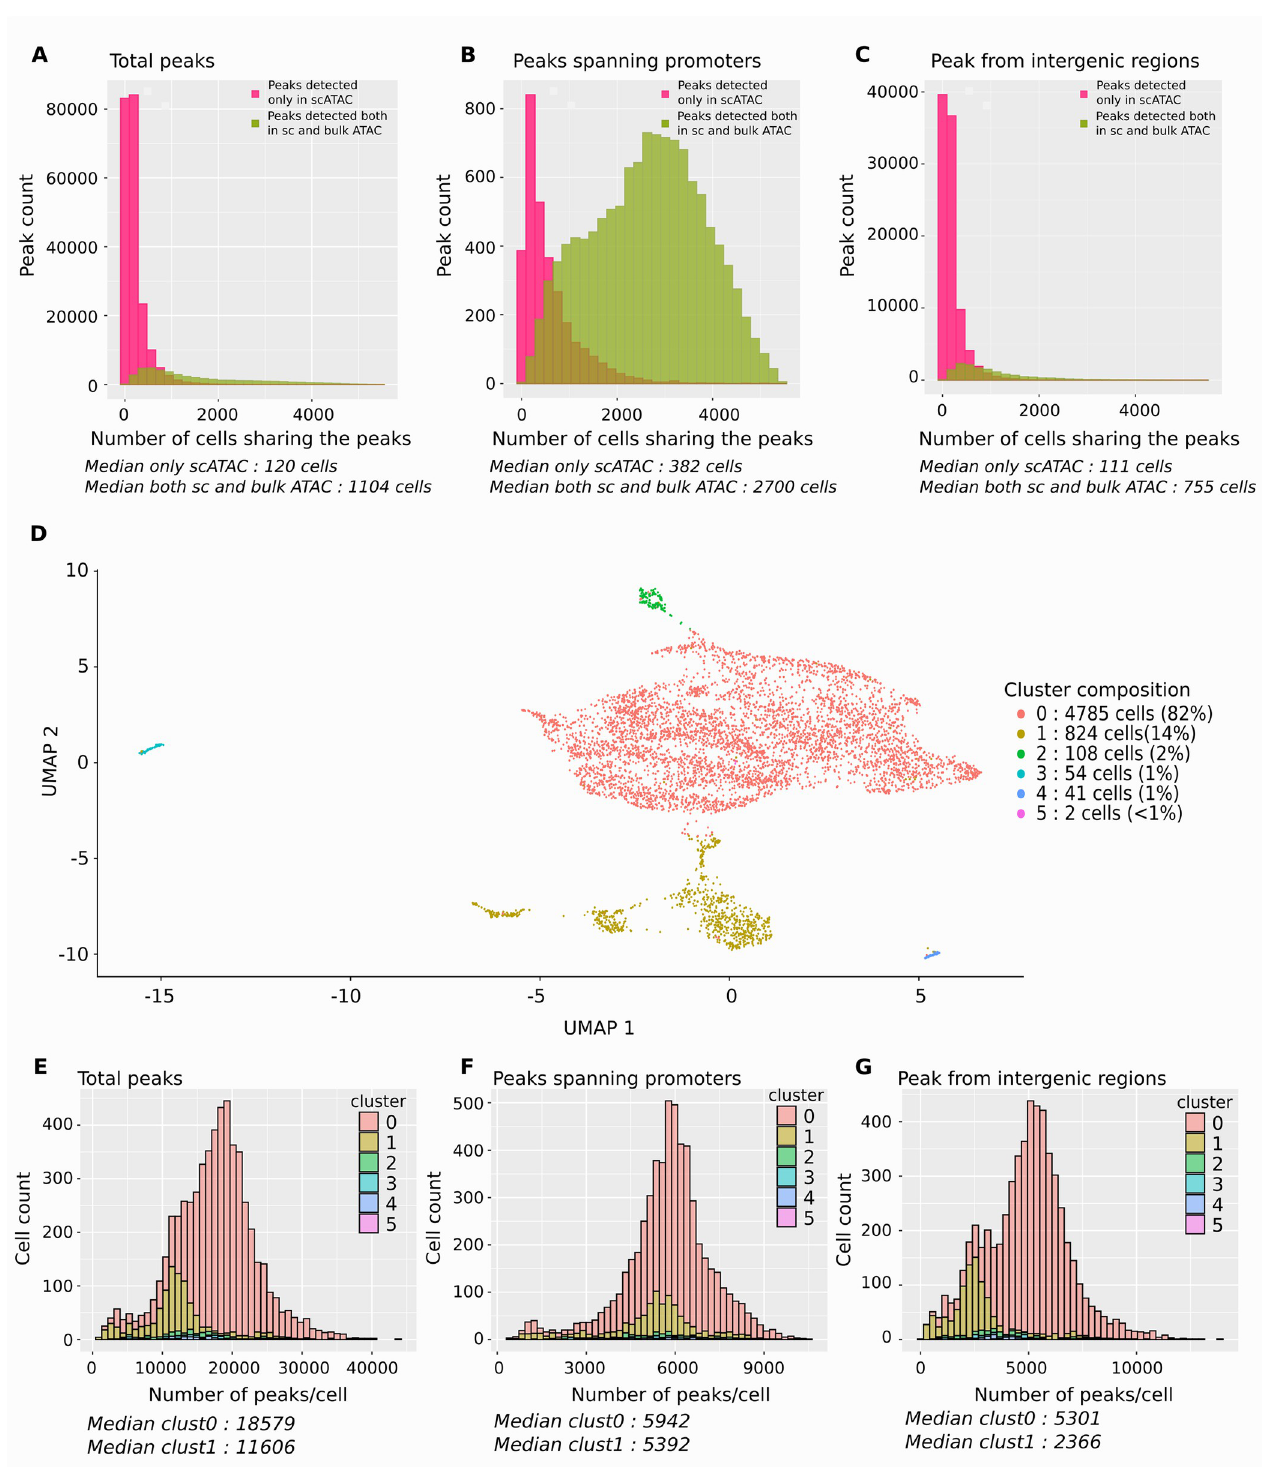
Fig 5. scATAC-seq analysis of chromatin accessibility at 24 h poststimulation. ( A ) Histogram of the distribution of the total number of peaks as a function of cells sharing them. The distribution of the peaks detected only by scATAC-seq are in pink, and those detected both by single-cell and bulk ATAC-seq are in green. The median numbers are indicated below the histogram. Note that the peaks detected by scATAC-seq only are shared by a low number of cells only, while those detected by both methods are present in a large number of cells. ( B ) Histogram of the distribution of the promoter-specific peaks as a function of cells sharing them. The color codes are the same as in ( A ). The peaks detected by both methods are shared by a very large number of cells. ( C ) Histogram of the